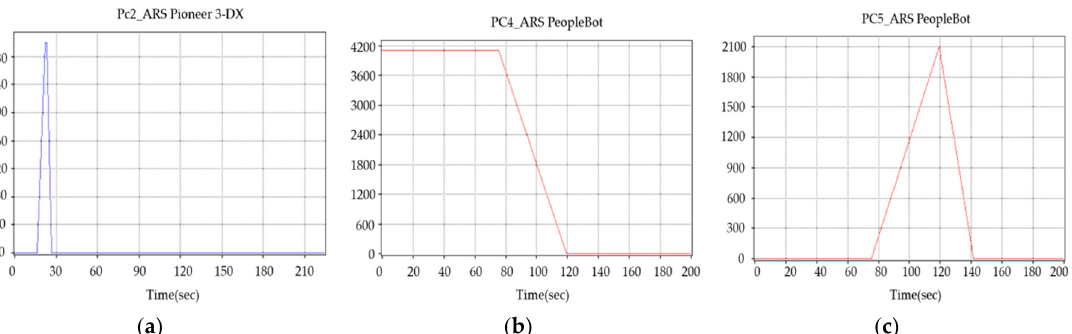
Figure 8. Continuous places evolution of ARS Pioneer 3-DX and ARS PeopleBot during the transport of the parts: ( a ) Pc2; ( b ) Pc4; ( c ) Pc5.